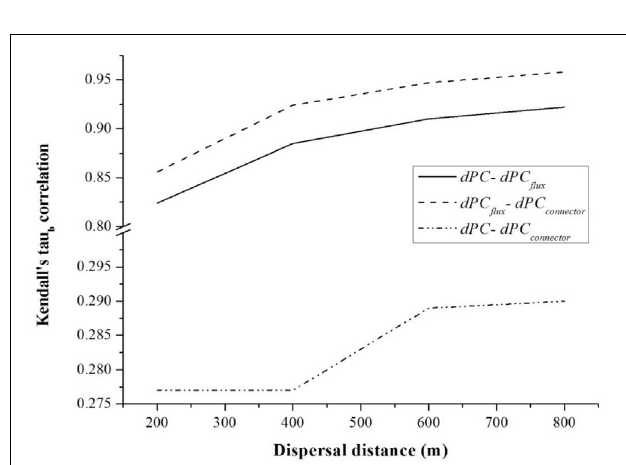
FIGURE 5 | Kendall’s rank correlations ( tau b ) between dPC , dPC flux , and dPC connector , at different dispersal